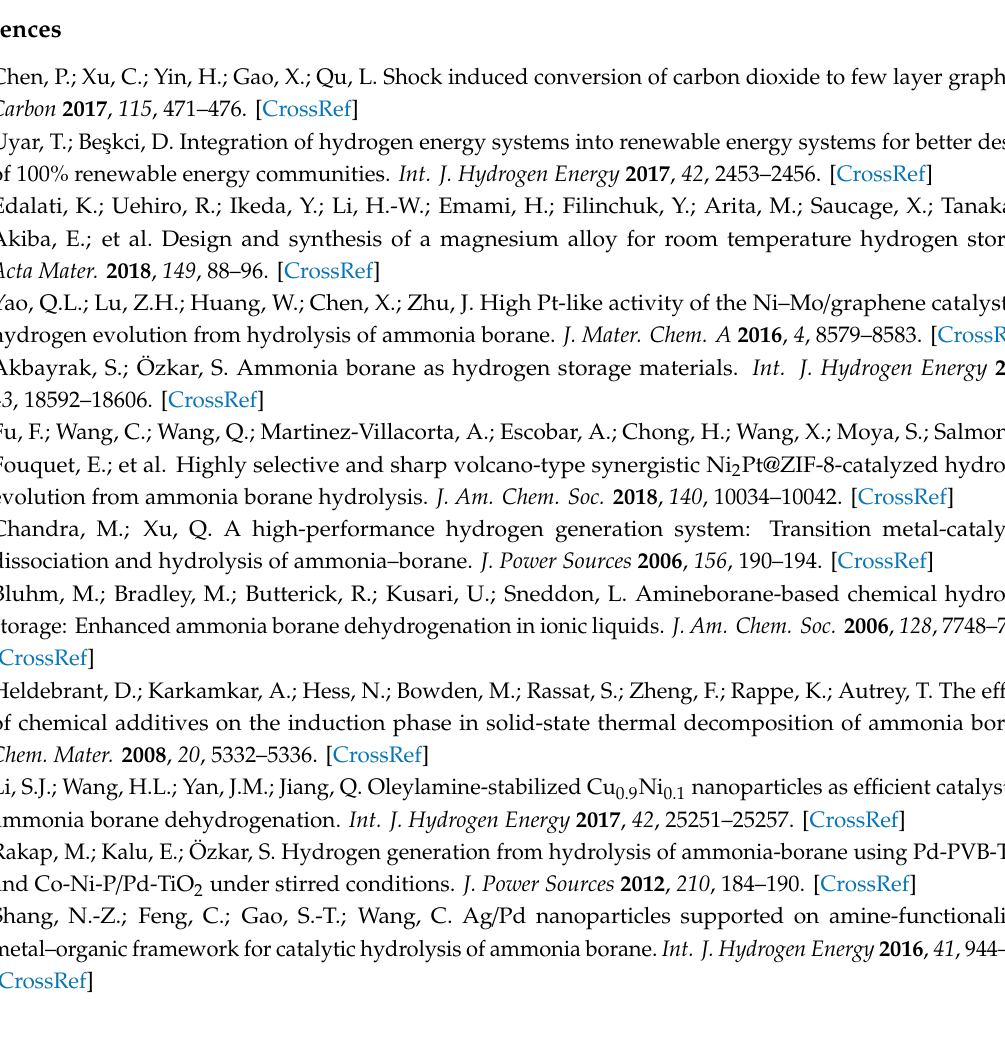
Figure S1: SEM images of the physical mixture of CuCo 2 O 4 and NiCo 2 O 4 (a, b) and EDS patterns on some selected nanoplatelets; Figure S2: TEM image of nanoparticles (a), HRTEM image of nanoparticles (b), TEM image of urchin-like microspheres (c), HRTEM image of urchin-like microspheres (d); Figure S3: N 2 absorption-desorption isotherms curves of nanoparticles (a), urchin-like microspheres (b) and nanoplatelets (c); Figure S4: XPS spectra of the CuCo 2 O 4 and NiCo 2 O 4 mixture; Figure S5: H 2 –TPR curve of the mixture of CuCo 2 O 4 and NiCo 2 O 4 ; Figure S6: Hydrogen evolution at di ff erent temperature (a,c) and the calculation of the activation energy for di ff erent catalysts (b,d); Figure S7: Hydrogen evolution at di ff erent recycle number when the CuCo 2 O 4 / NiCo 2 O 4 nanoplatelets act as catalysts; Figure S8: SEM image (a) and the XRD pattern (b) of the used Ni 0.5 Cu 0.5 Co 2 O 4 nanoplatelets after catalytic reaction; Figure S9: XPS spectra of CuCo 2 O 4 / NiCo 2 O 4 nanoplatelets after catalytic reaction; Table S1: Comparison of the relative contents of Ni 2 + and Co 2 + on the surface of the composition and